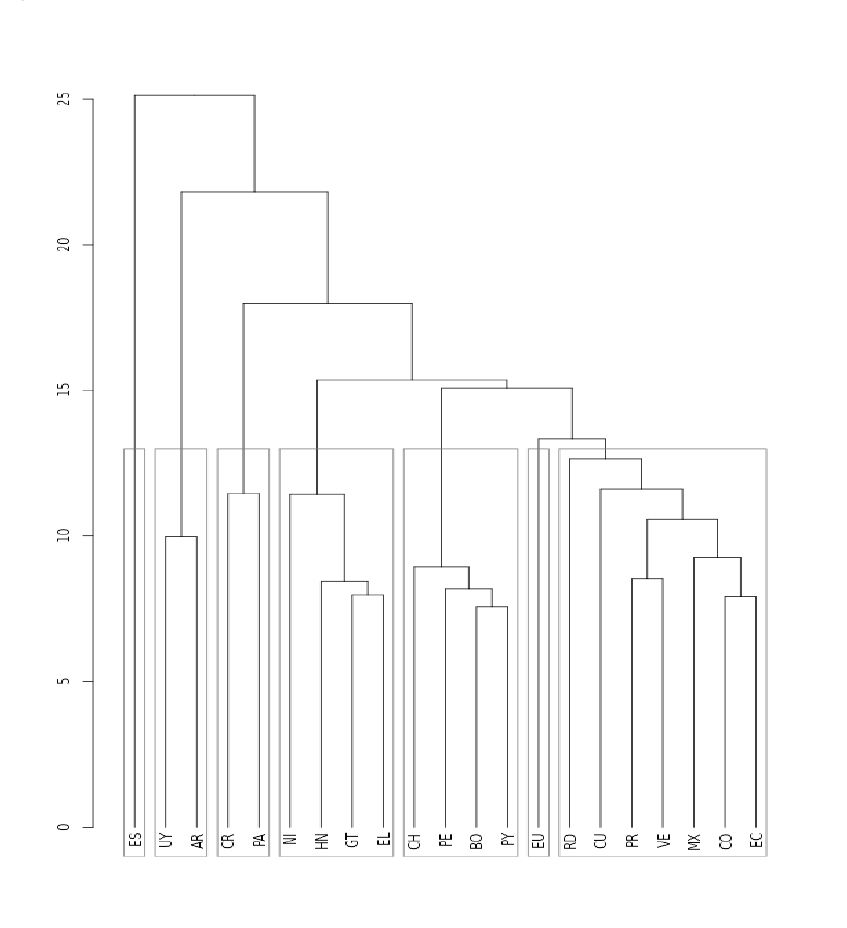
Figure 8. Hierarchical Clustering Dendogram Using the Features from the One Rule